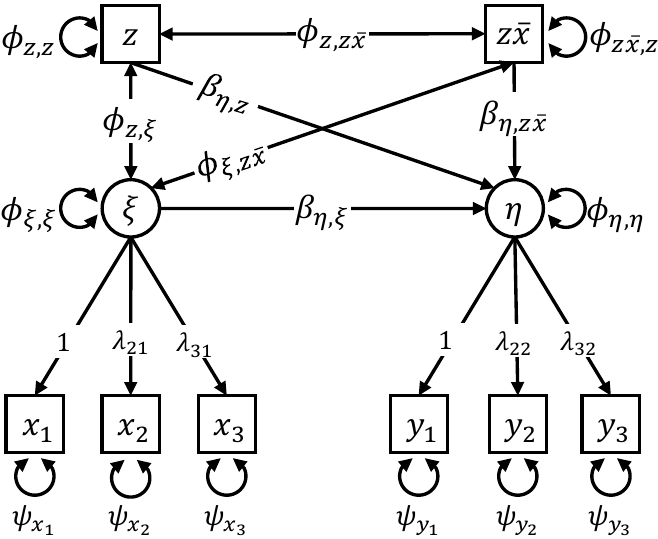
Figure 10. Path diagram of the interaction model with a product term.